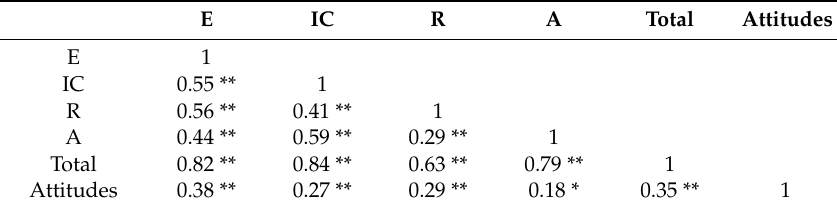
Table 3. Correlations between HP-CSS and attitudes to communication